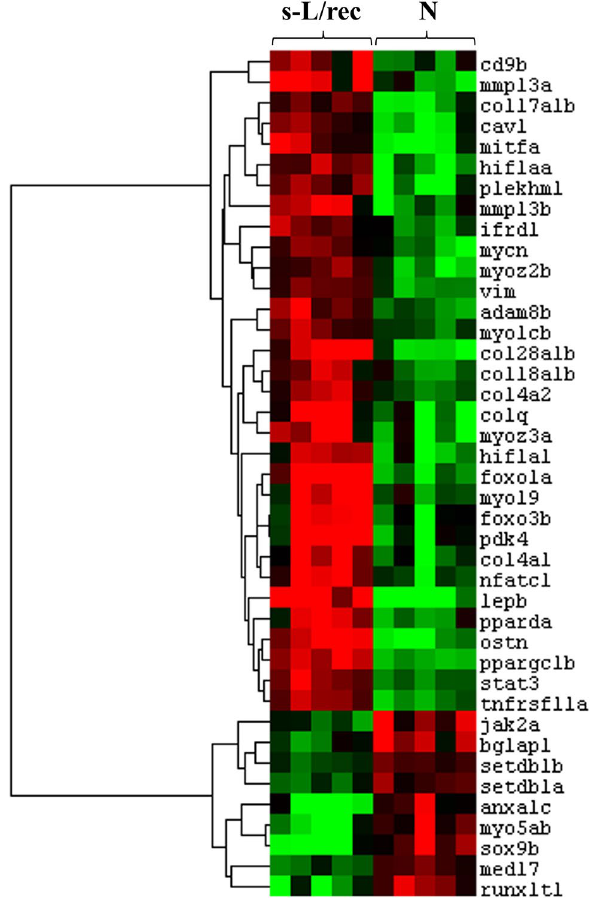
Figure 3. Heat map representing the relative mRNA expression levels of genes differentially expressed ( p < 0.01) between normal (N) and recovered (s-L/rec) individuals, involved in bone remodeling and/or muscle